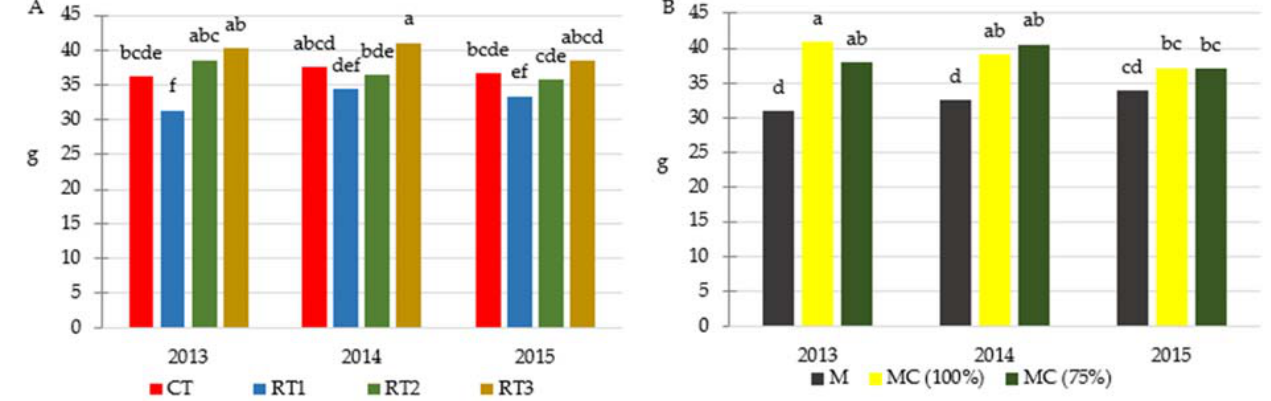
Figure 4. Interactive dependencies of the tillage systems ( A ), weed control methods ( B ), and research years in determining thousand-kernel weight of spelt wheat. CT—conventional tillage; RT1, RT2, RT3—reduced tillage; M— mechanical; MC (100%)—mechanical and chemical (dose of herbicides 100%); MC (75%)—mechanical and chemical (dose of herbicides 75%). Different letters denote significant differences ( p ≤ 0.05). The same letter represents not significantly different values ( p ≤ 0.05).